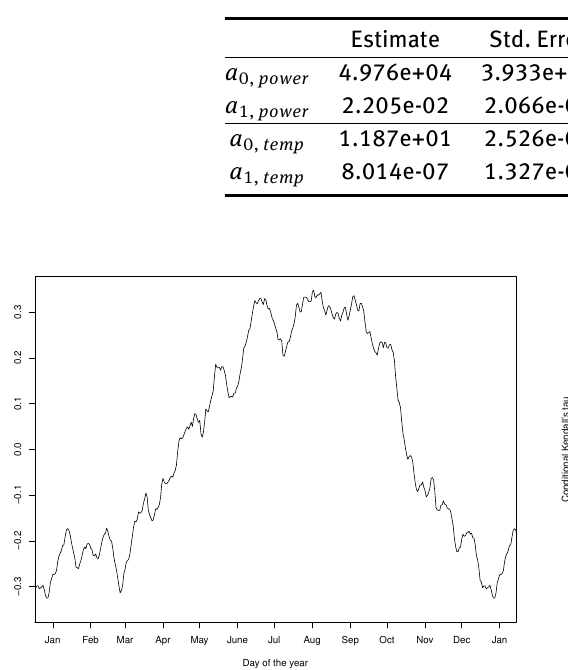
Table 5: Statistics for the OLS estimators of (5) and (6).